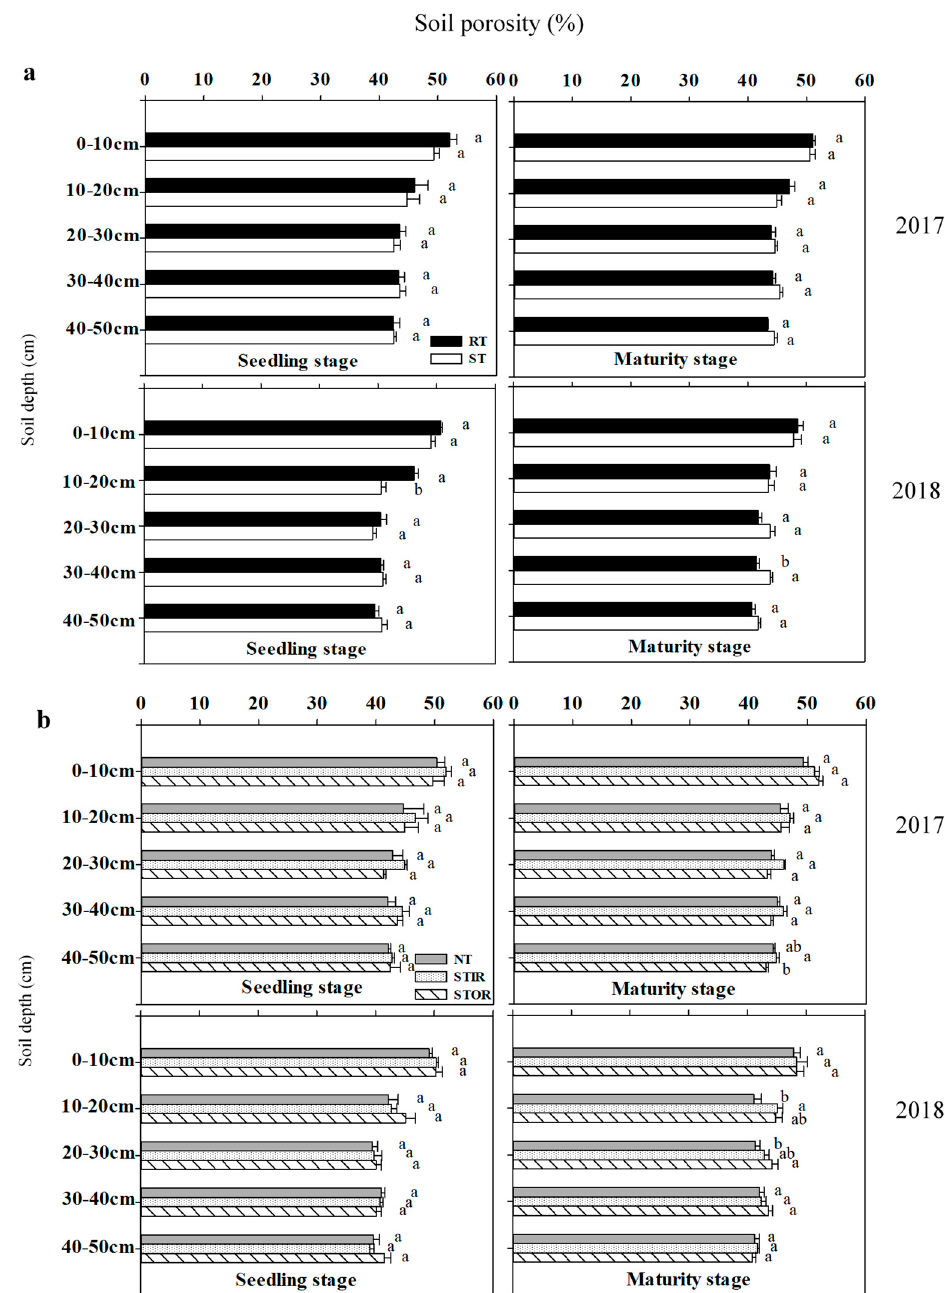
Figure 2. Effects of different tillage practices on soil porosity in maize season. ( a ) wheat season tillage; ( b ) maize season tillage. RT: rotary tillage; ST: subsoiling; STIR: inter–row subsoiling tillage; STOR: on–row subsoiling tillage. Different letters indicate statistically significant differences at the p < 0.05 level (ANOVA and Duncan’s multiple range test; n = 3), the same letters are not significantly different between two treatments.